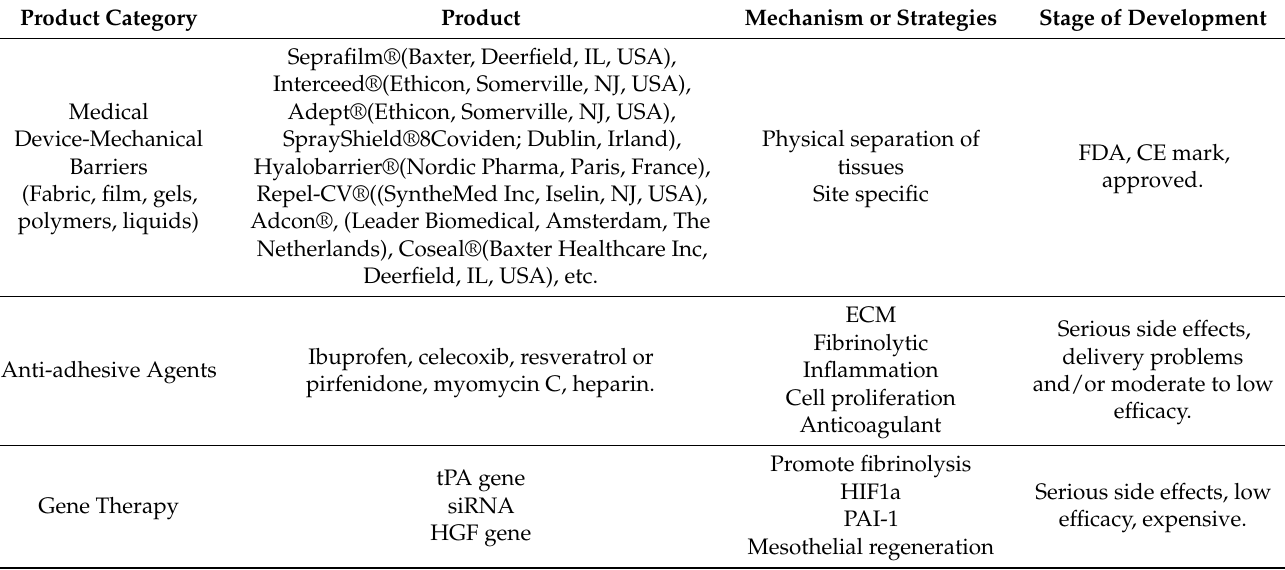
Figure 2. Pathogenesis of adhesion formation. Reproduced with permission from: De Wilde, R.L., Trew, G. & on behalf of the Expert Adhesions Working Party of the European Society of Gynaecological Endoscopy (ESGE) [5] . As discussed, the current barrier therapies aim to isolate the surgical tissue, in an effort to promote proper wound healing in the initial postoperative phase, yet do not address the underlying mechanism of adhesiogenesis. In 2020, a Cochrane review did not